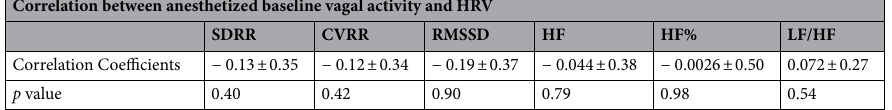
Correlation between anesthetized baseline vagal activity and HRV